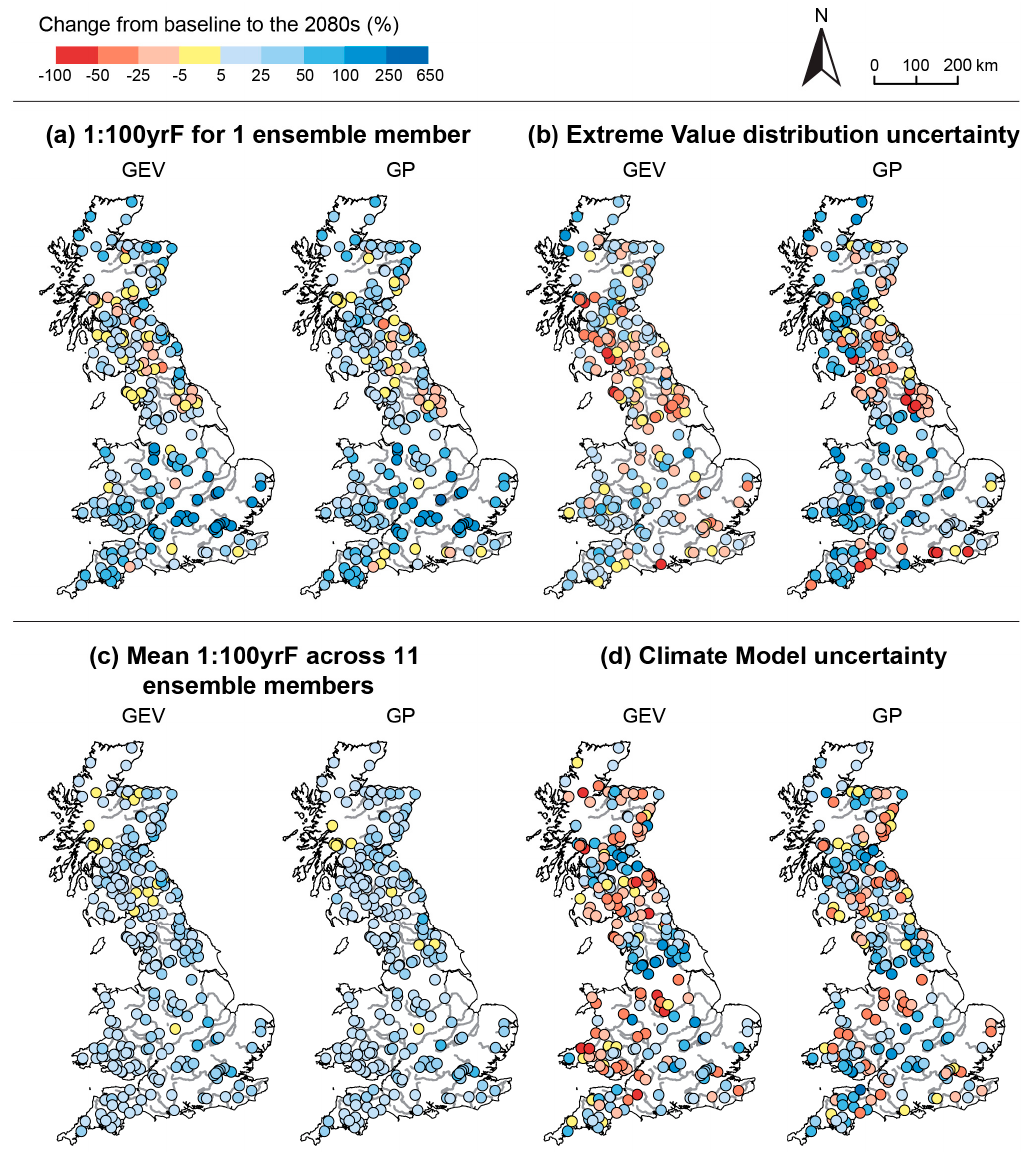
Figure 4. Results across Great Britain of change from the baseline to the 2080s for the GEV (on the left) and the GP (on the right) models. Step 1: ( a ) Change in 1:100 yrF (for ensemble member afgcx); and ( b ) change in Extreme Value Distribution parameter uncertainty (relative coefficient of uncertainty). Step 2: ( c ) Change in mean 1:100 yrF (across the 11 ensemble members); and ( d ) change in Climate Model uncertainty (relative standard deviation).